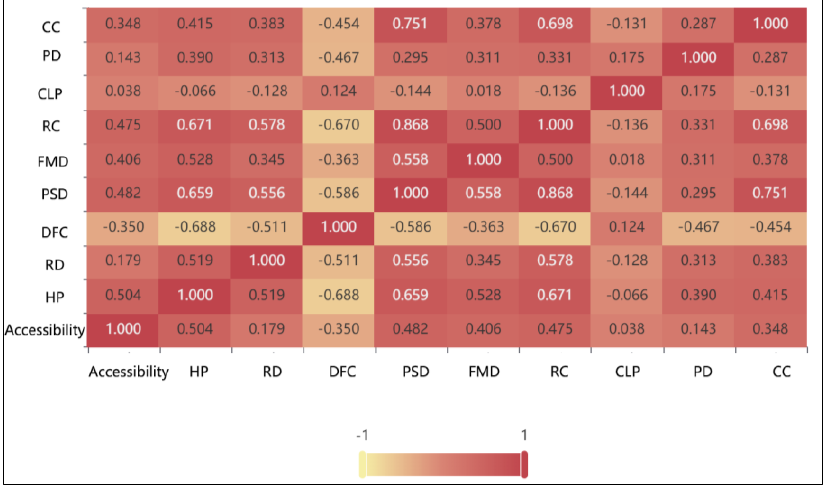
Figure 8. Correlation analysis matrix.